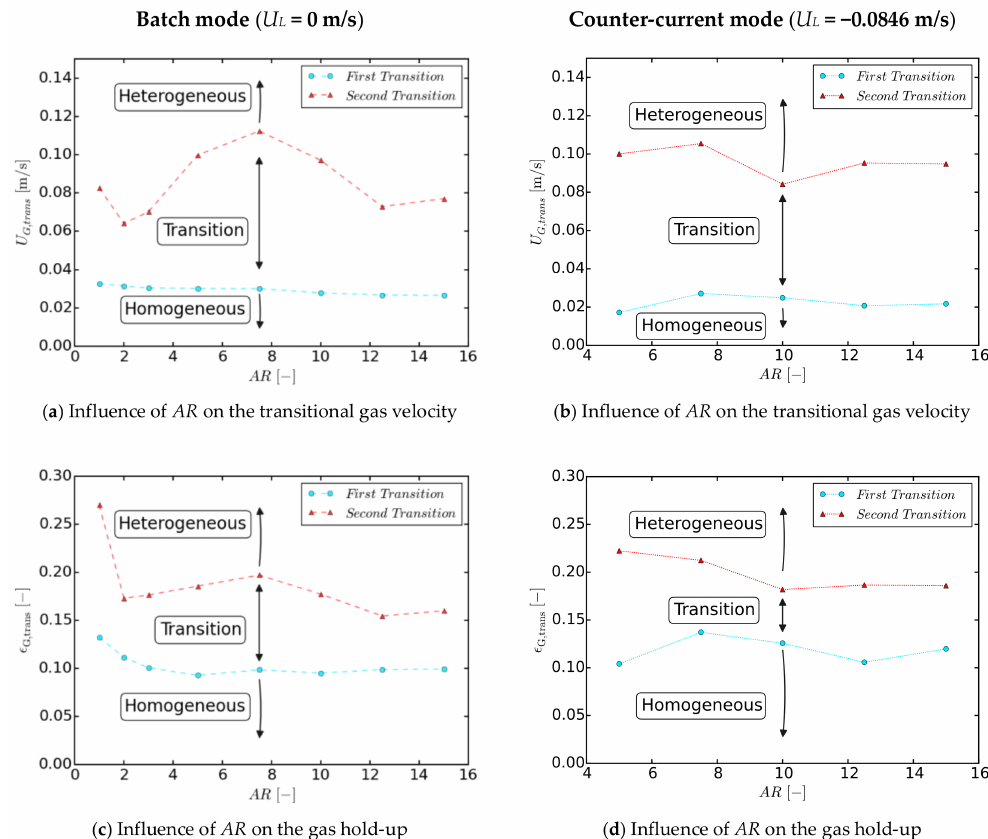
Figure 8. Influence of AR and U L on flow regime transition points—data obtained by